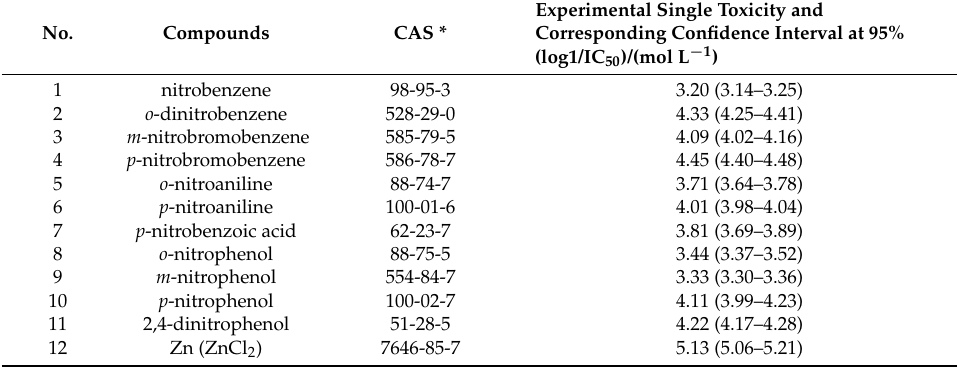
Table 2. Single toxicity and corresponding confidence interval at 95% of nitro-substituted benzenes and Zn to P. phosphoreum